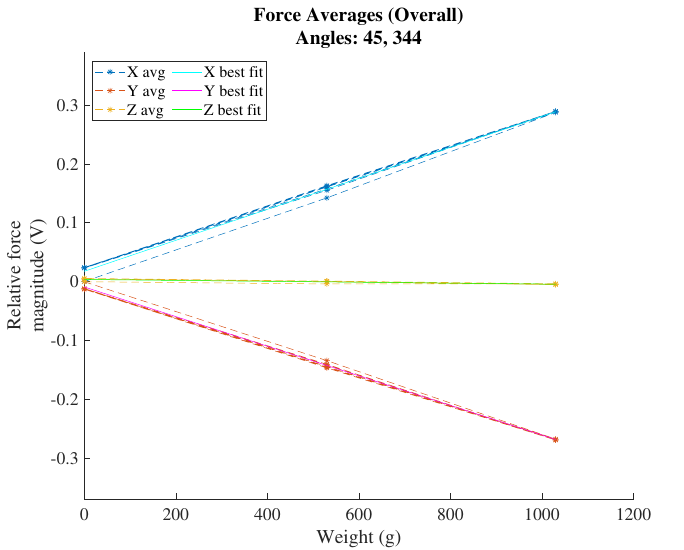
Figure 17. Voltage response to 3D calibration loading in the +X − Y direction. All three forward- backward cycles are plotted in dashed lines, and corresponding lines of best fit are solid.